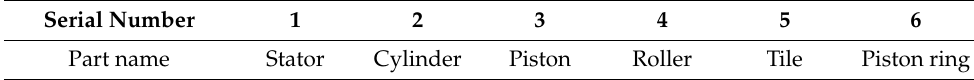
Figure 2. Motor components. Table 1. The main components of the motor are shown in Figure 2.